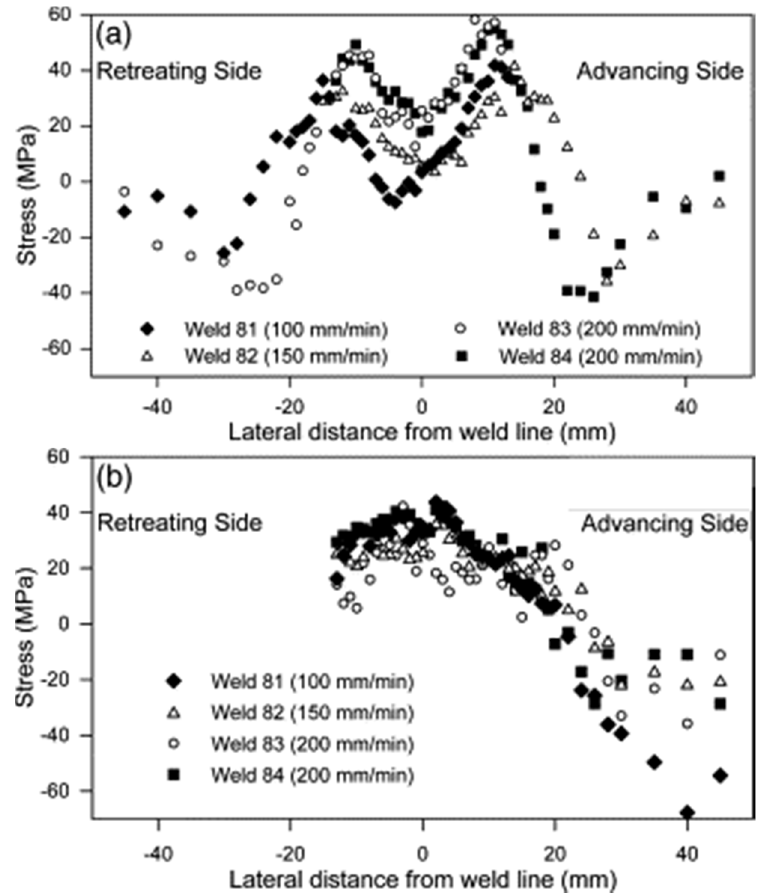
Figure 6. ( a ) Longitudinal and ( b ) transverse residual stresses as a function of lateral distance from the weld line [67].